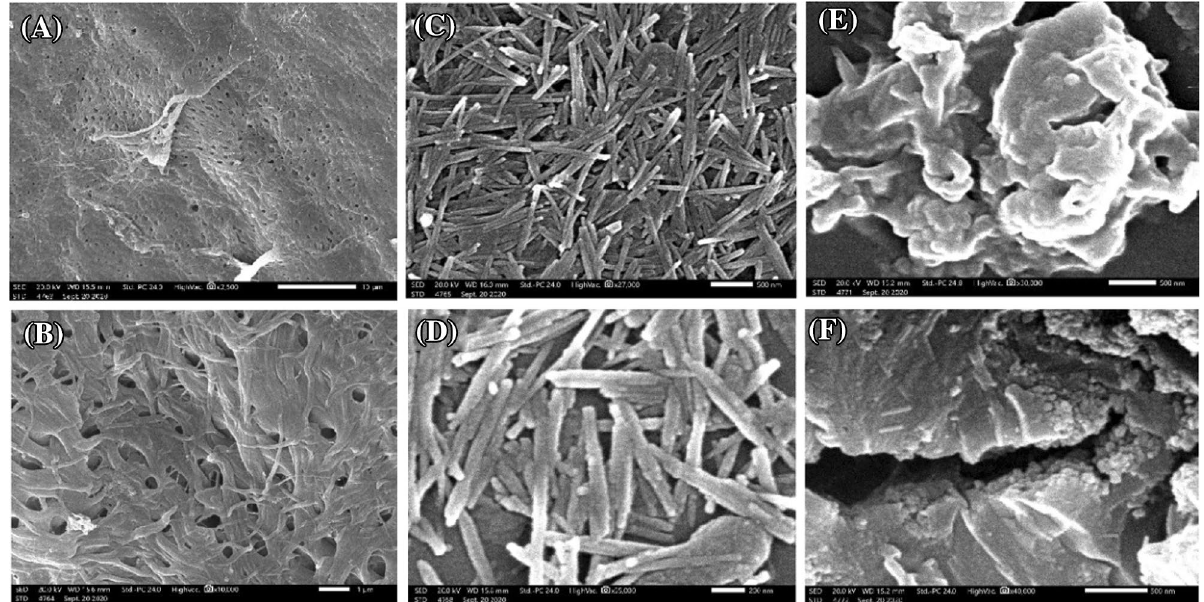
Figure 4. SEM of ( A , B ) NH 2 Cs, ( C , D ) ATP and ( E , F ) ATP@Fe 3 O 4 -NH 2 Cs composite .